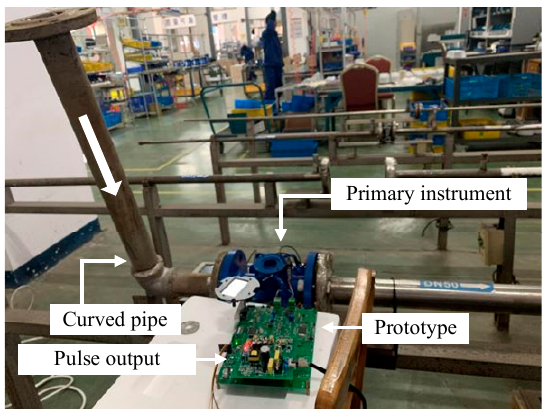
Energies 2021 , 14 , x FOR PEER REVIEW Figure 13. The site of the unstable flow field experiment of the curved pipe. Figure 13. The site of the unstable flow field experiment of the curved pipe.